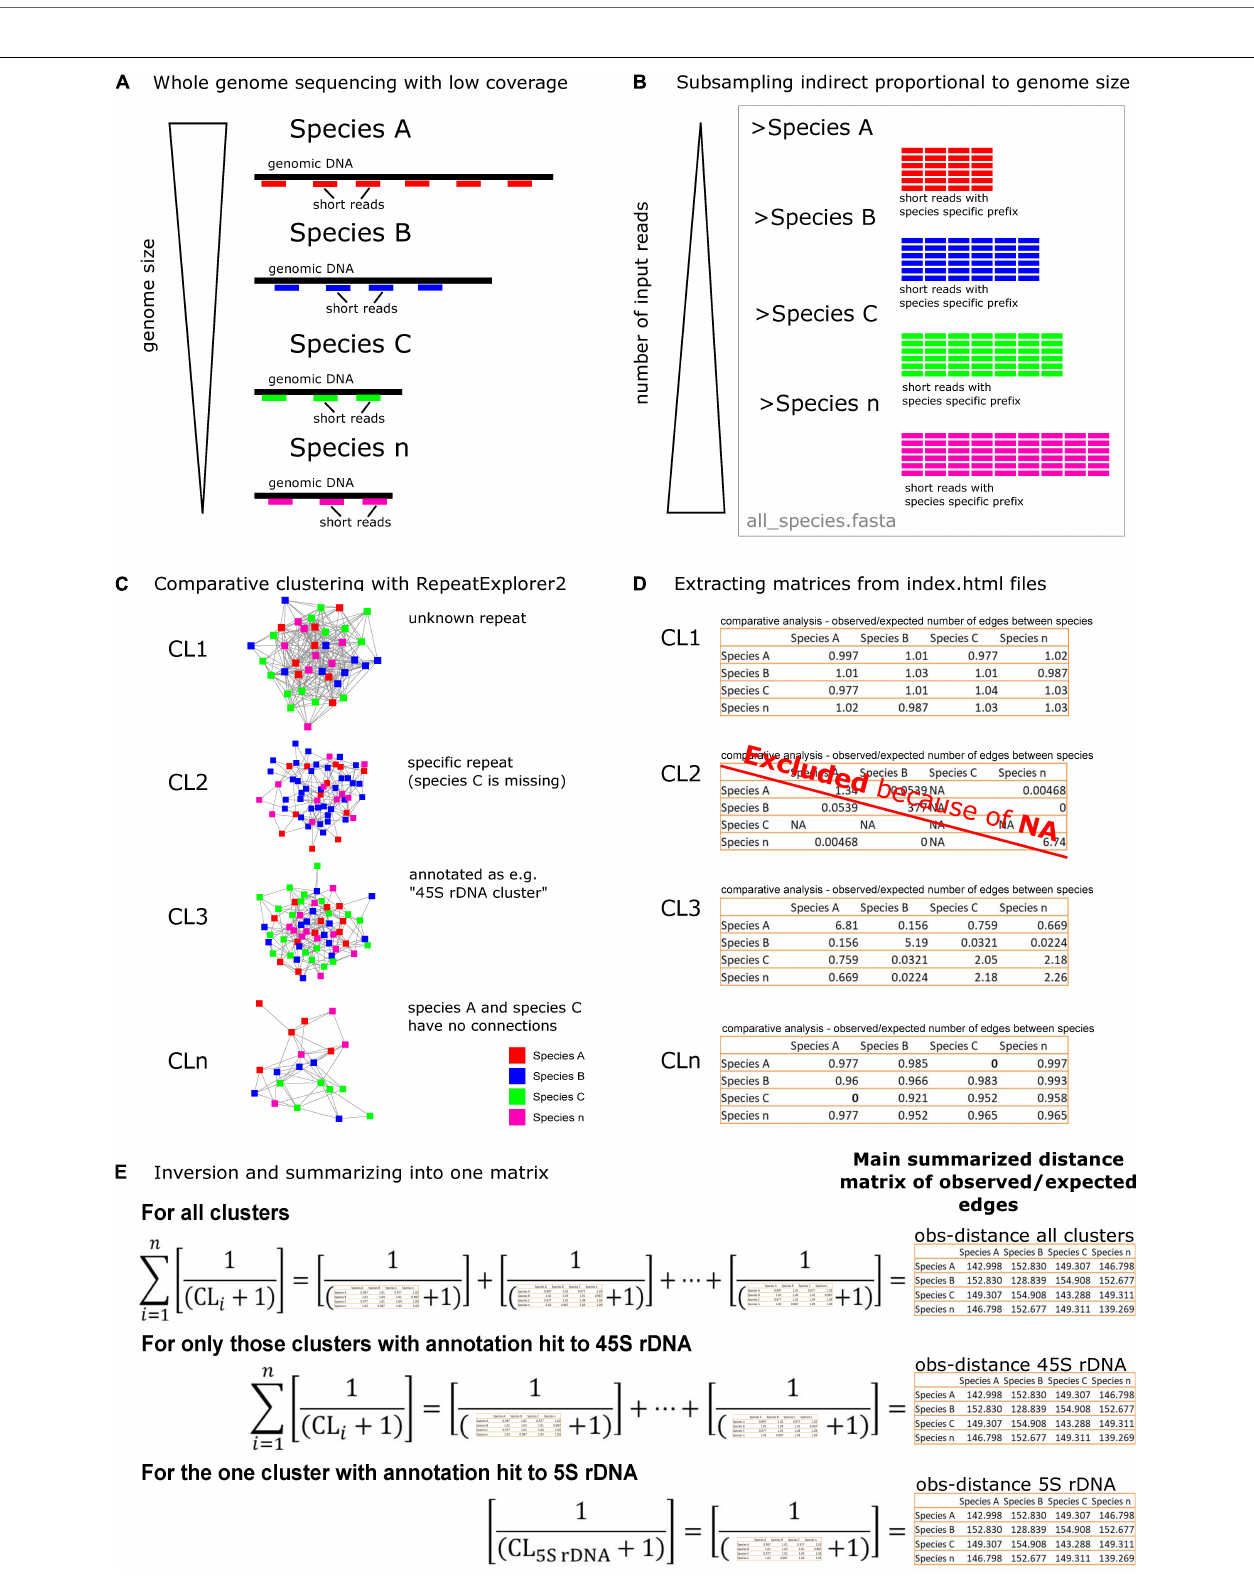
FIGURE 2 | A schematic overview of the method used to analyze phylogenetic signals in repeatome data. (A) The comparative study was based on Illumina short read sequences from different species with unequal genome sizes. (B) Reads from different species were concatenated with indirect proportional number to their genome sizes, creating one FASTA file (C) . A comparative clustering with the RepeatExplorer2 (RE) pipeline was conducted on a mixed data set. The resulting graphs